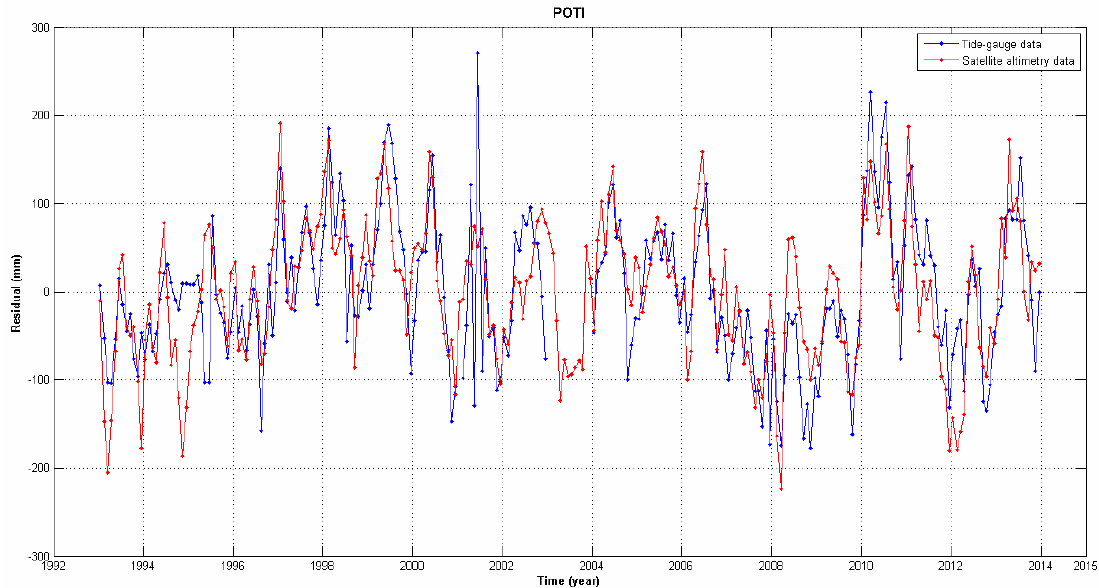
Figure 2. Detrended sea level change time series at Poti tide gauge site discrepancies between the time series of two techniques, especially for the tide gauge sites with short time-spans. The distances between 12 tide gauge sites and the corresponding altimetric grid points, and the trend estimations are presented in Table 2. To compare the trends estimated from satellite altimetry data at exact location of the tide gauge site, also a neighbouring area (buffer frame) with a diameter of 0.125° around each tide gauge site is defined (Figure 1). In this way in order to derive the trend at the tide gauge site from altimetry data, it is utilized from the altimetric grid points in buffer frame. The trend values are computed using a weighted average interpolation algorithm at each tide gauge site. According to this algorithm, the weighting is based on the inverse of the square of the distance between the tide gauge site and the neighbour altimetric points. Here, the weighting and the boundary of the buffer are chosen empirically. However, interpolated trend values are not very different from the trends obtained at the closest altimetric grid points. So, these values are not included in this study.